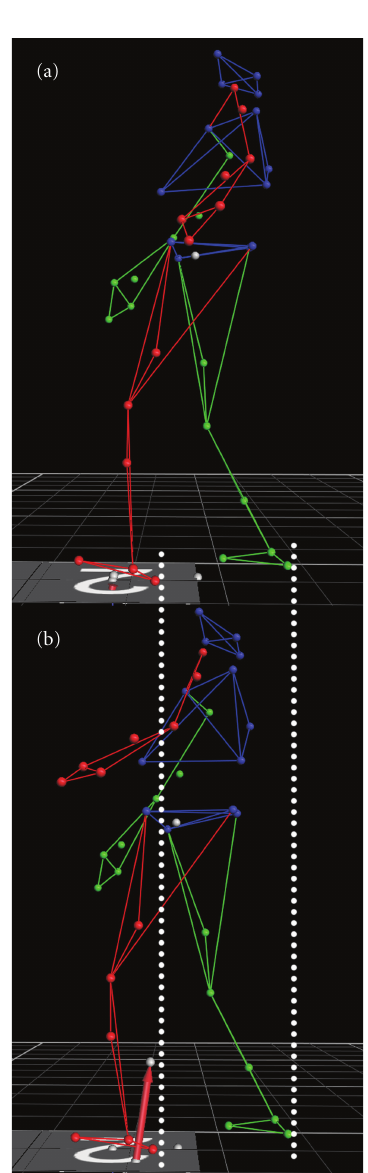
Figure 1: Visual representation of marker data during ON (a) and OFF (b) medication testing trials. White lines depict the equality of step length (Mean (SD): (a) 25.94 (10.33), (b) 25.72